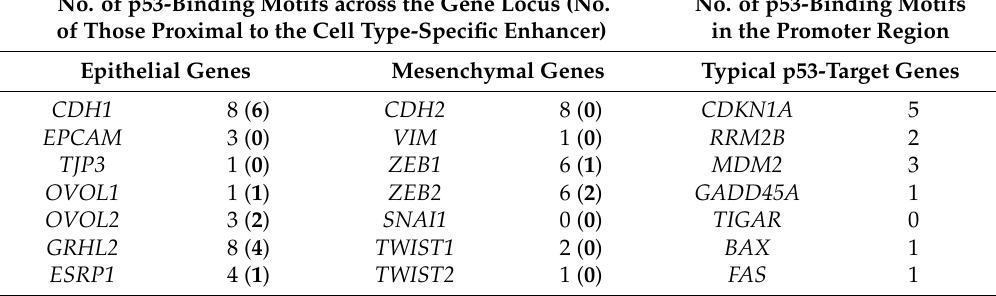
Table 1. The number of motifs for the binding of p53 across the indicated epithelial gene or mesenchymal gene loci (from − 10 kb of the transcription start site [TSS] to the end of exons) is listed. The number of motifs for the binding of p53 found in the promoter regions (+/ − 5 kb of TSS) of the known p53-target genes is also listed. The motifs for the binding of p53 were identified using the “p53scan” algorithm [27], in which no spacers are allowed between two decameric half-sites. No. of p53-Binding Motifs across the Gene Locus